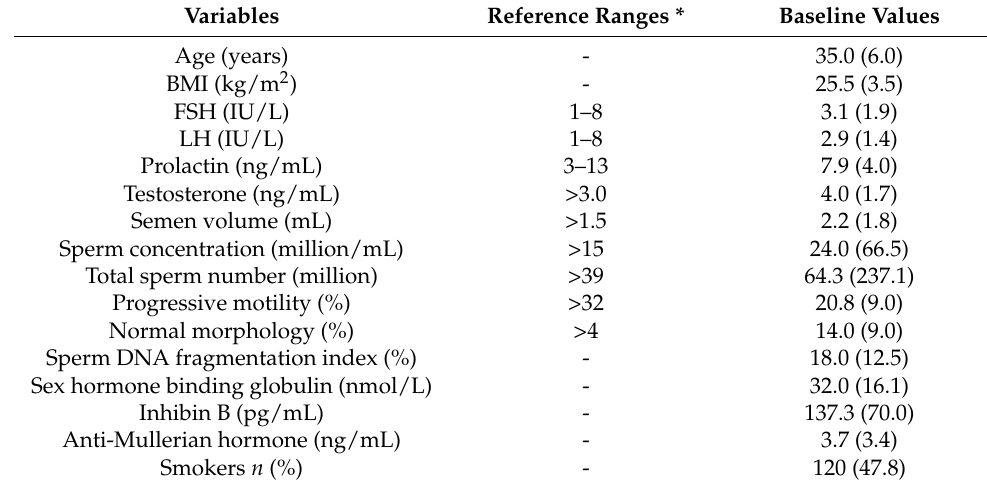
Table 2. Baseline patient’s characteristics. Data are expressed as median (interquartile range).